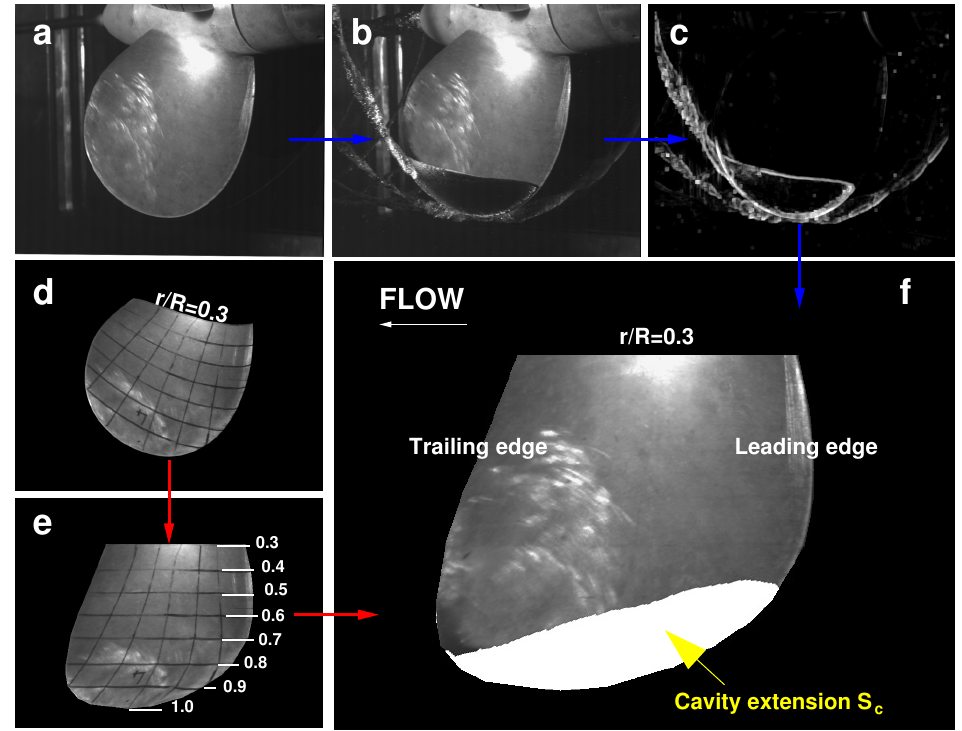
Figure B1. Image cross-correlation procedure: ( a ) template image; ( b ) cavitation pattern image; ( c ) correlation image; Mapping procedure: ( d ) distorted image; ( e ) plan-view image; ( f ) processed image showing the cavitation extension S c